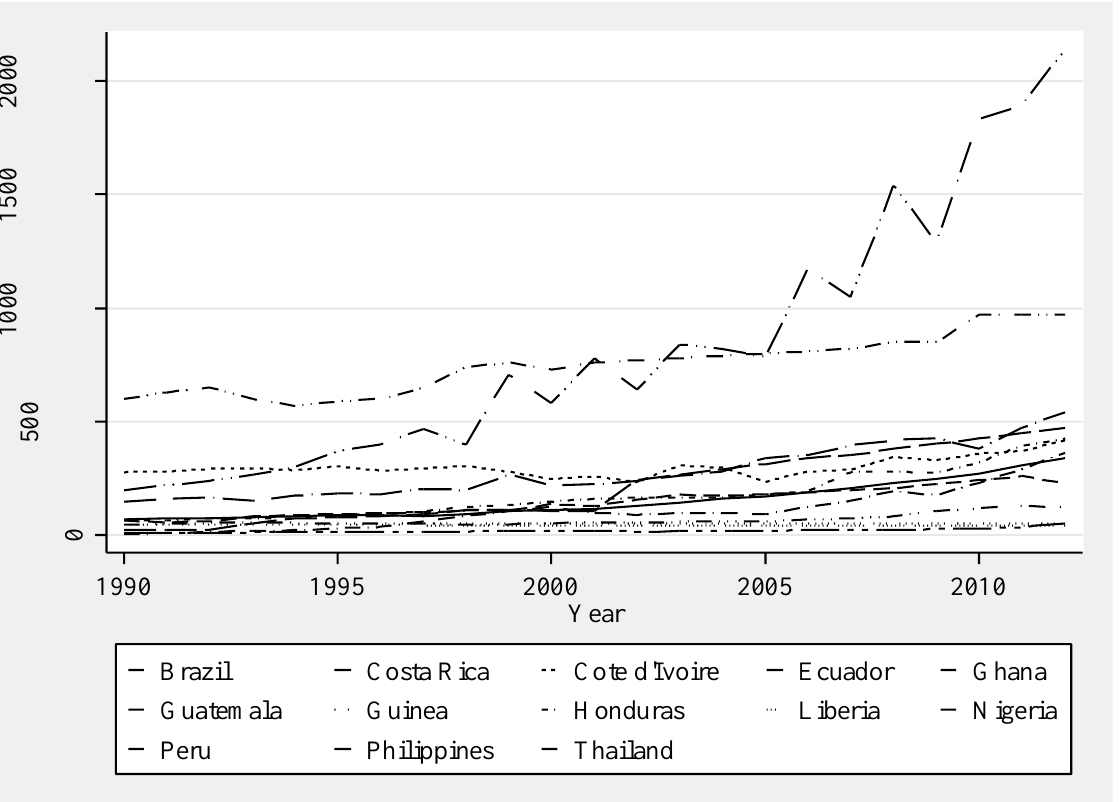
Figure 2. Palm Oil Production in Thirteen Peripheral Countries, 1990 –